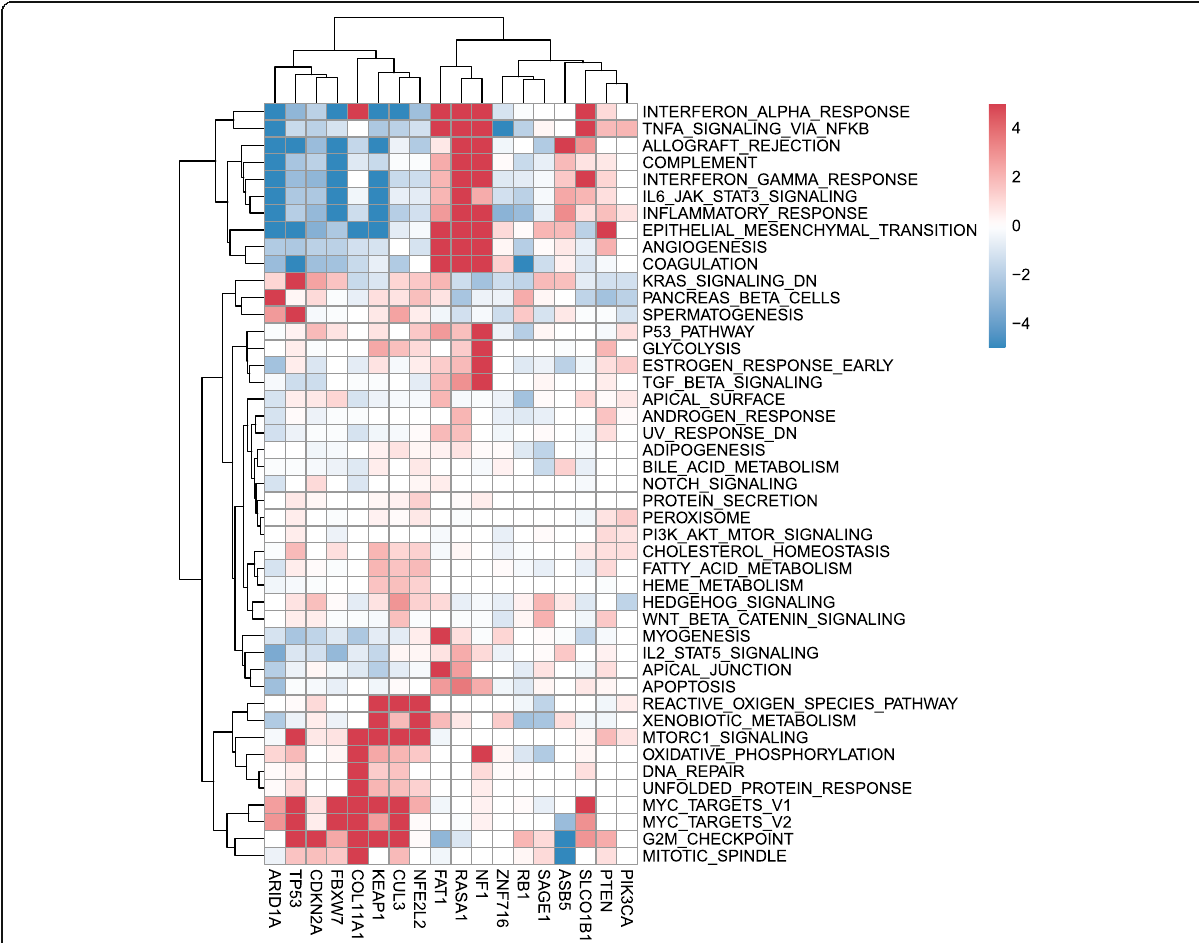
Fig. 3 Heatmap about the potential down-stream pathways of the SMGs. GSEA is performed to evaluation the significance of each pathway. Each cell is colored according to the transformed GSEA-based FDR value where the absolute value is equal to the – log10(FDR) and the sign represents the regulation direction (+/ − , up/down